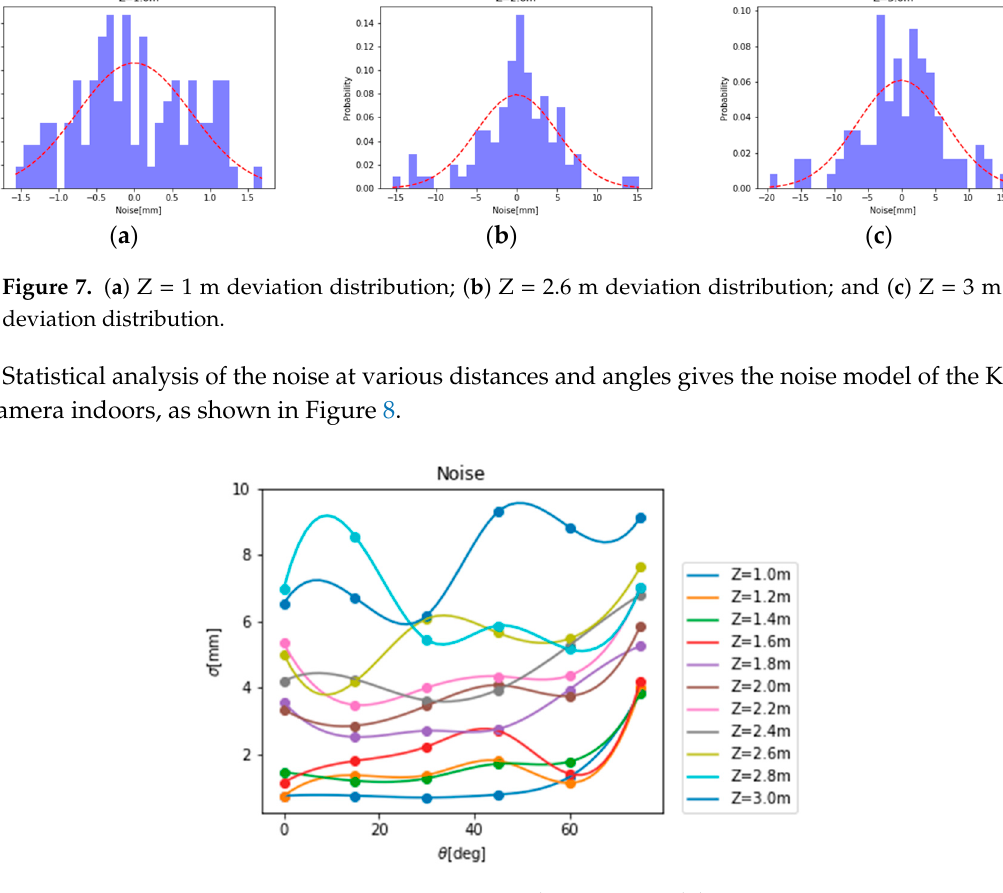
Figure 9. ( a ) Z = 1.2 m deviation distribution; ( b ) Z = 2.6 m deviation distribution; and ( c ) Z = 2.8 m deviation distribution. Statistical analysis of the noise at various distances and angles gives the noise model of the Kinect V1 camera outdoors, as shown in Figure 10. Figure 10. Kinect V1.0 outdoor noise model.